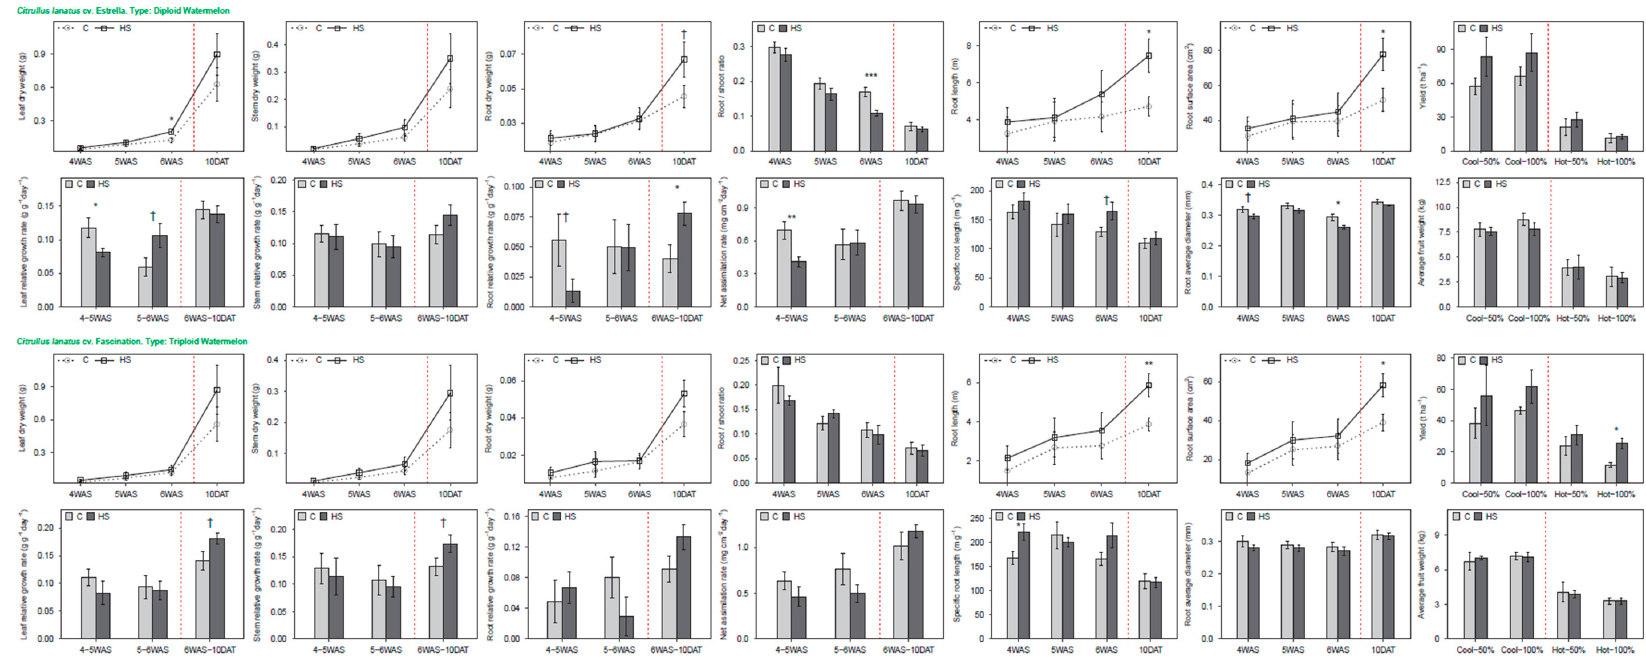
Figure 4. Watermelon seedling and transplant quality traits as affected by media amendments, yield traits as affected by amendments and irrigation during the two growing seasons. †, *, **, *** show signi fi cant di ff erence comparing HS to control (C) at P ≤ 0.1, 0.05, 0.01, and 0.001, respectively.